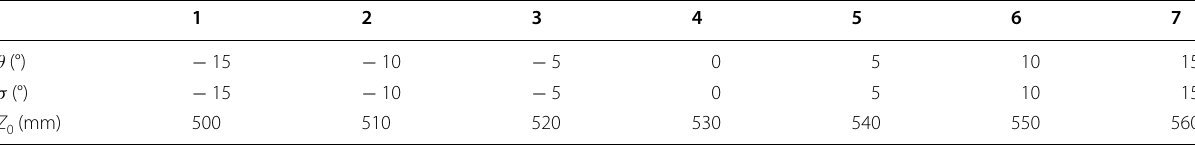
Table 2 Levels of three independent end